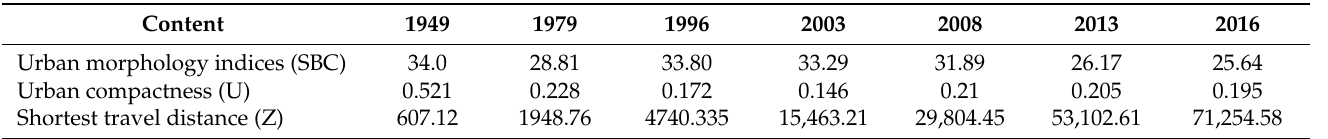
Table 3. Results of urban morphology indices, degree of urban compactness and shortest travel dis-